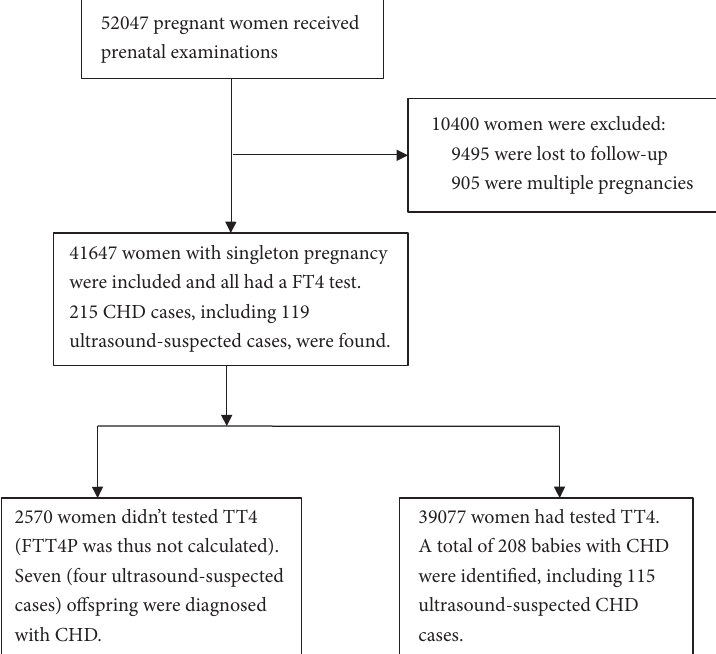
Figure 1: Flow chart of the study.